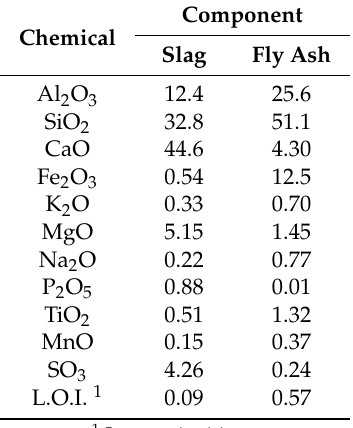
Table 1. Chemical composition of the slag and fly ash (wt.%).